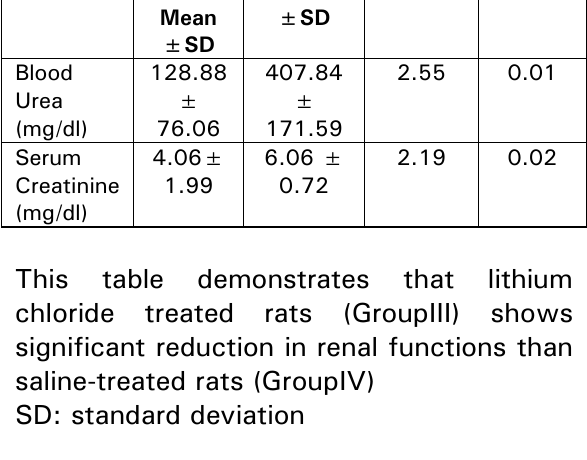
Table2: comparison between day3 pathology scores of rats with cisplatin-induced AKI (GroupI) and saline-injected rats (GroupII)